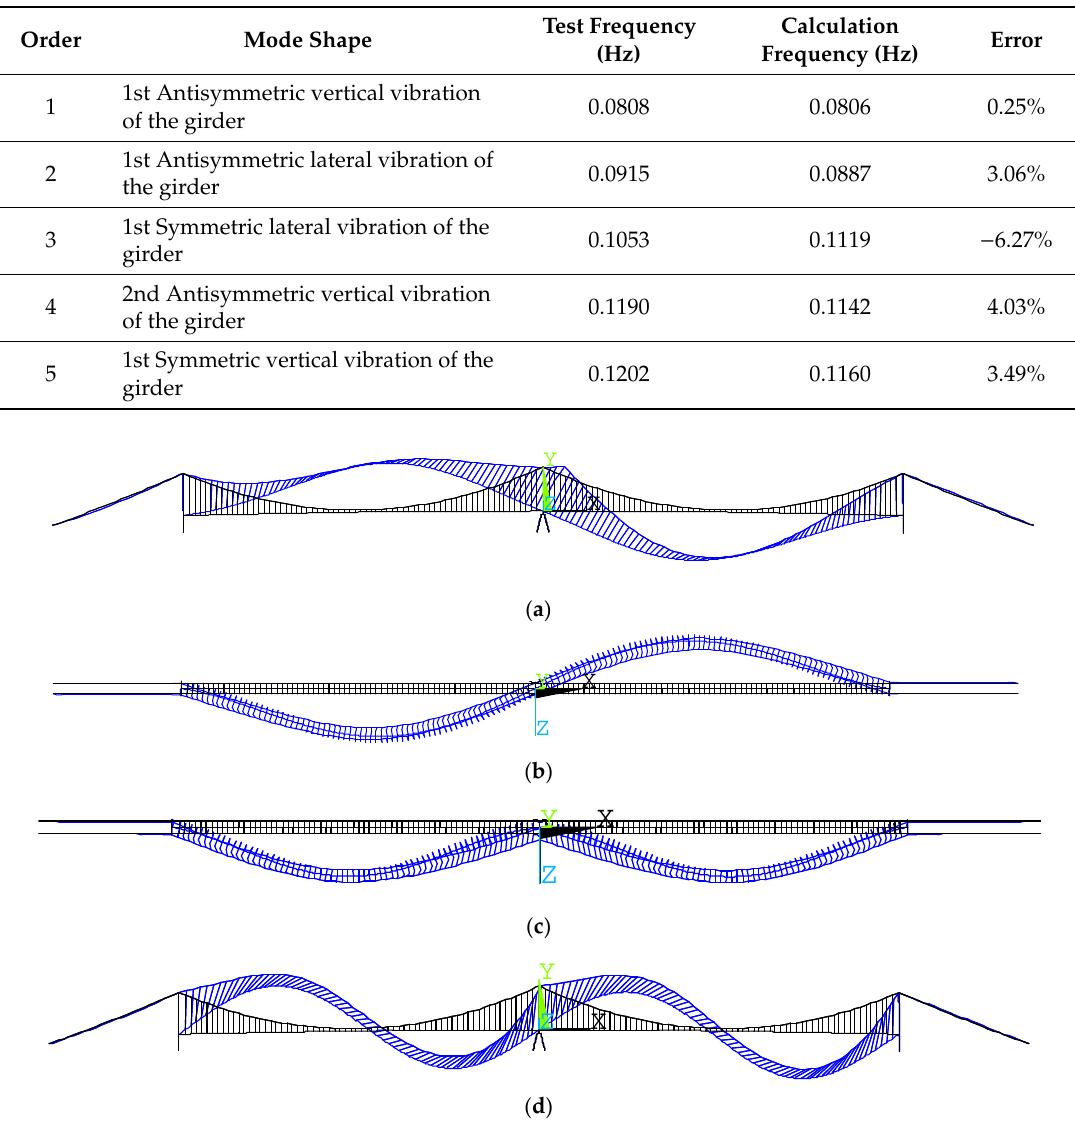
Figure 8. Typical mode shape simulated by the finite element model. ( a ) Order 1, elevation view, ( b ) Order 2, plan view, ( c ) Order 3, plan view, ( d ) Order 4, elevation view.